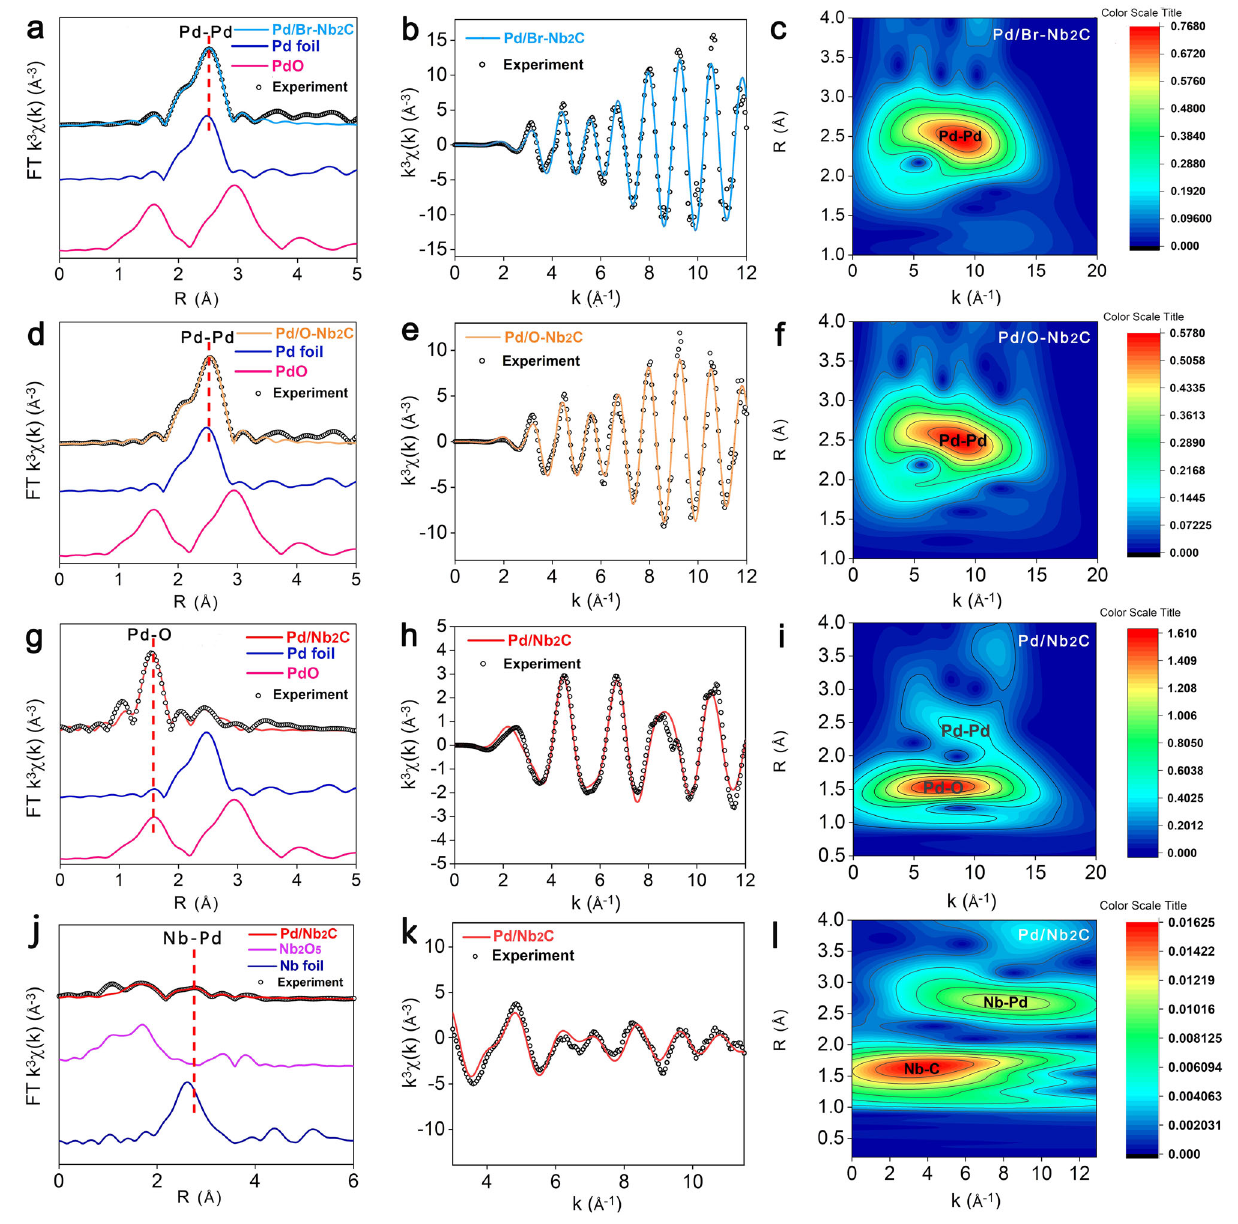
Fig.3|StructurescharacterizationofPd/Nb 2 CMXenes.a – c XAFSanalysisofPd/ Br-Nb 2 C. a R-spaced FT-EXAFS of Pd K -edge. b k-space, and ( c ) WT-EXAFS plots of Pd. d – f XAFS analysis of Pd/O-Nb 2 C, ( d ) R-spaced FT-EXAFS of Pd K -edge, ( e